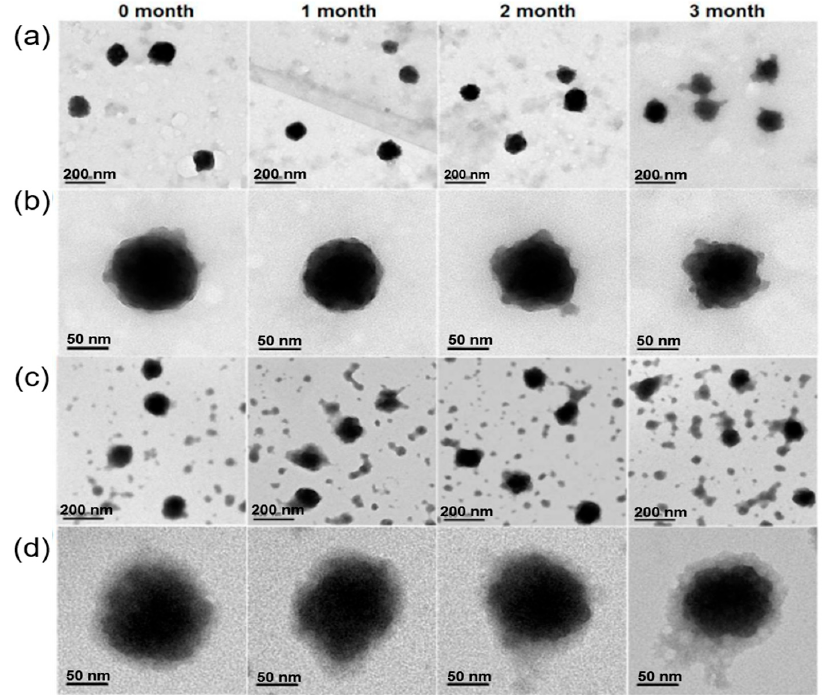
Figure 5. Long-term stability of PVP-coated BSA@ZIF-8 nanoparticles. ( a ) TEM images of PVP-coated